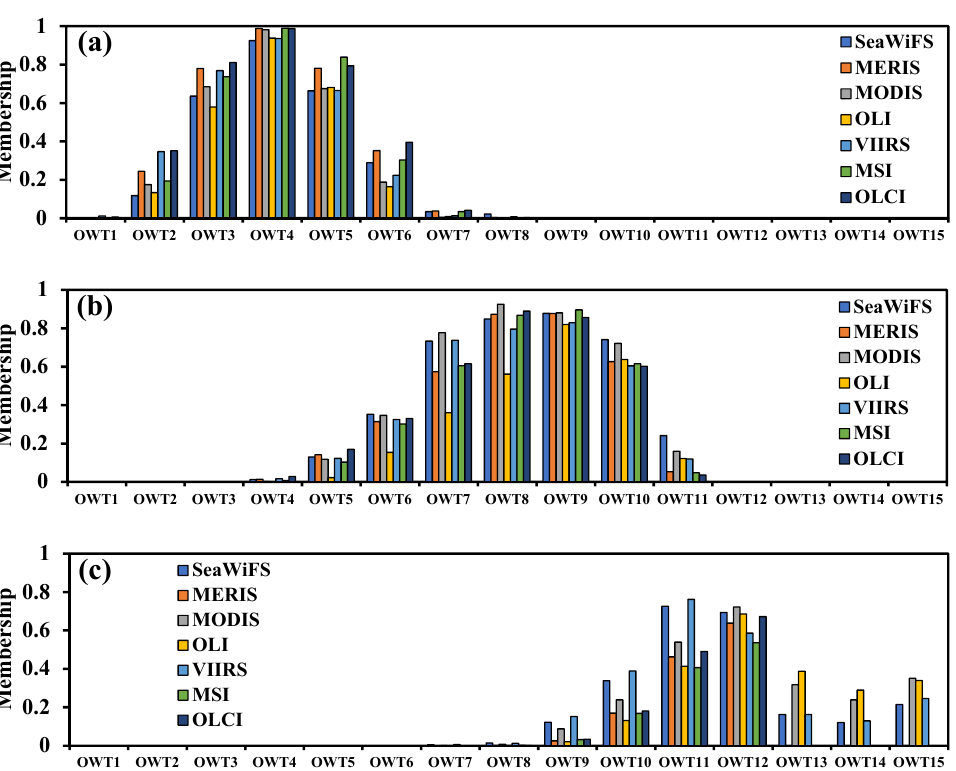
Figure 8. The U-OWT dominant OWT of ( a ) the Pearl River Estuary’s Landsat-8 OLI image on 23 October 2017, and ( b ) the Pearl River Estuary’s Sentinel-3A OLCI image on 23 October 2017. The land and cloud pixels are masked. 3.2.3. Sensitivity Analysis The local sensitivity of the U-OWT schemes corresponding to OLI, MODIS, and OLCI are seen in Figure S3, Figure S4, and Figure 9, respectively. Taking OLCI as an example, the perturbation of R rs values in the wavelength range of blue bands (400 − 500 nm) mainly affected the oligotrophic and mesotrophic water classes (OWT1-8), in terms of the domi- nant OWT and the membership values. The increase in blue band R rs values could have decreased the OWT class numbers, while the decrease in blue band R rs values could have increased the OWT class numbers. Additionally, the perturbations of the green bands (500 − 600 nm), red bands (600 − 700 nm), and near-infrared bands (700 − 800 nm) R rs values mainly affected the mesotrophic (approximately OWT5-10), eutrophic (approximately OWT9-12), and over-eutrophic (approximately OWT13-15) U-OWT classes, respectively.